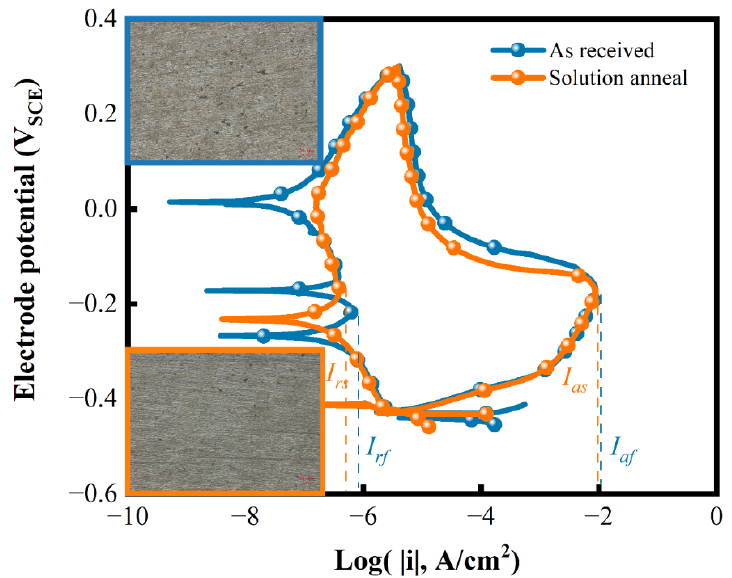
Figure 4. The DL-EPR test result of the as-received failed tube and the solution-annealed